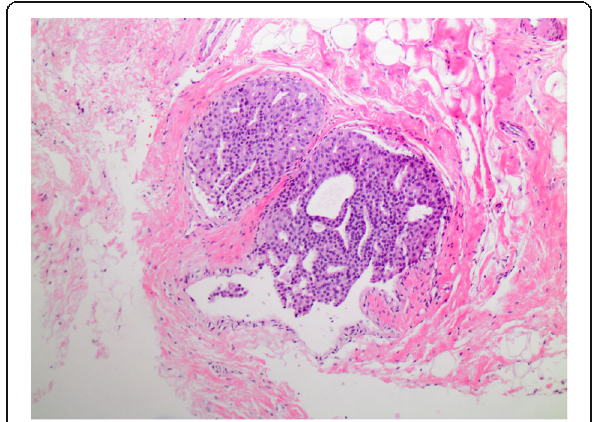
Fig. 5 Patient #3 (H&E, 10x) a 52 year old woman with an ultrasound-guided CNB with focal atypical ductal hyperplasia